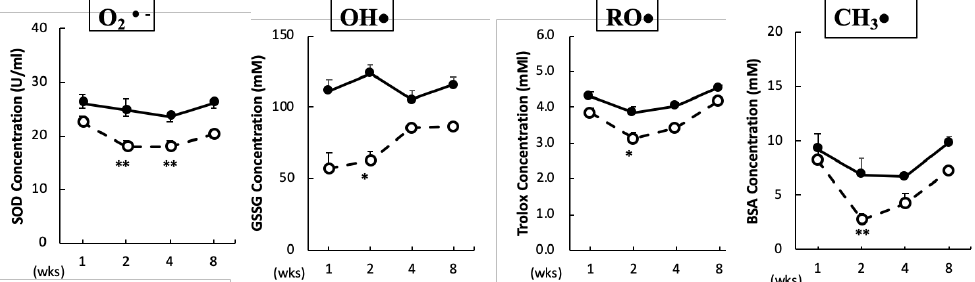
Figure 1. Free radical scavenging capacity in plasma. Animals were treated as described in the Methods Section. Plasma samples in each group were measured at the indicated times. Values represent mean ± SD ( n = 3 to 6). Solid line, control and dotted line, bisphenol A (BPA). * p < 0.05, ** p < 0.01 vs. control group (a two-way ANOVA).